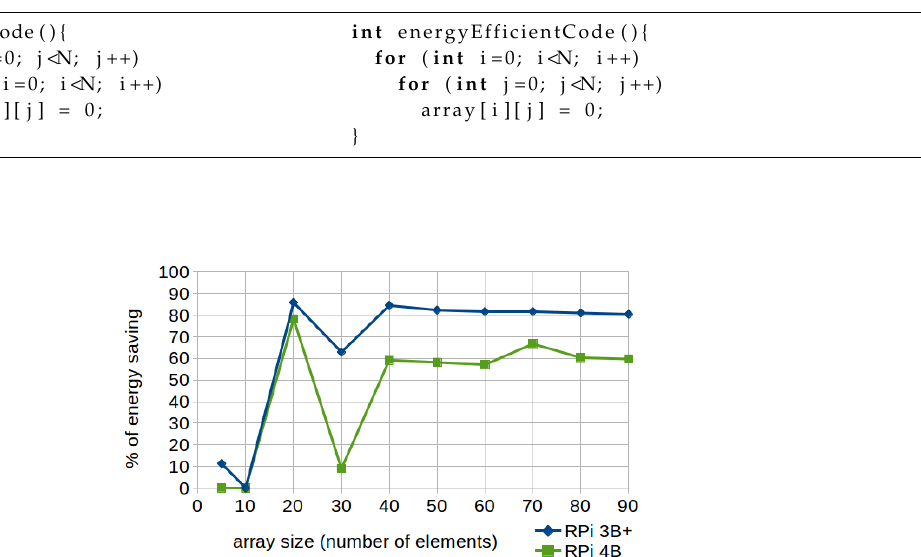
Figure 5. Row-major accessing. Percentage of energy saving according to the matrix size in RPi 3B+ and 4.